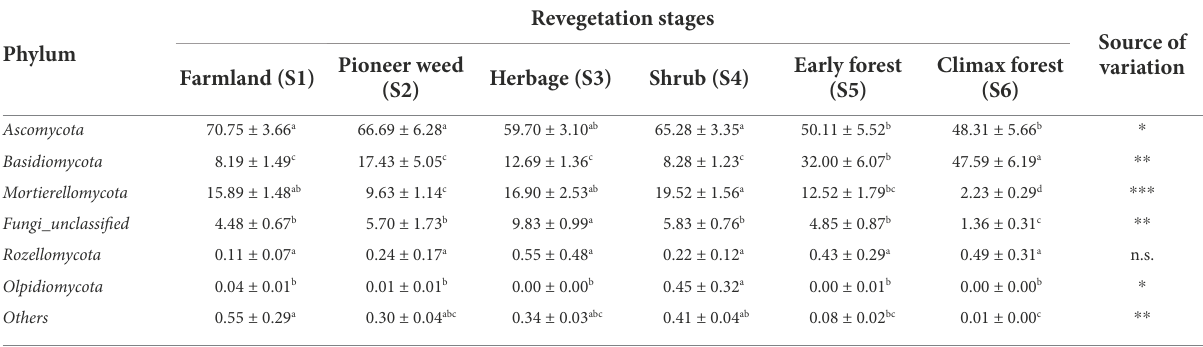
TABLE 2 Relative abundance (% of individual taxonomic groups) of the dominant fungal phyla (mean ± SE, n = 4) present in the soil (0–20 cm depth) microbial communities during various revegetation stages in the Loess Plateau of China.